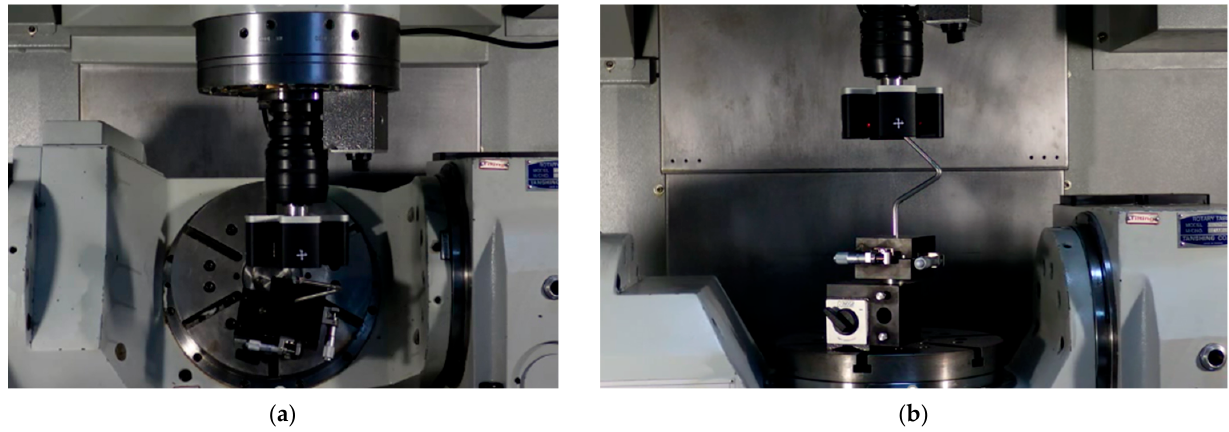
Figure 15. The picture of the Laser R-test: ( a ) installation for measuring the A-axis and ( b ) installation for measuring the C-axis.